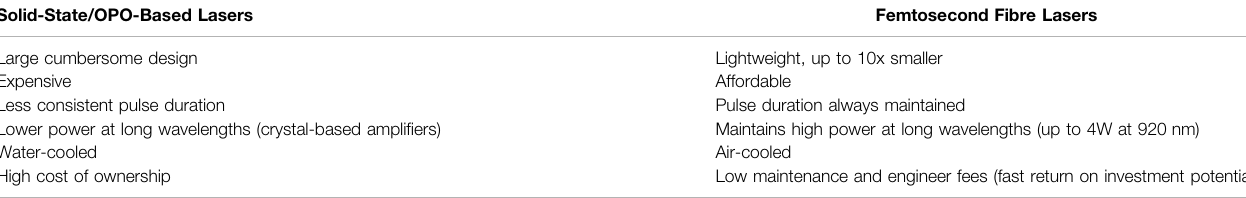
TABLE 2 | Bene fi ts associated with Fibre lasers over traditional solid-state and OPO lasers (adapted from ref (RPMC, 2020)) Solid-State/OPO-Based Lasers